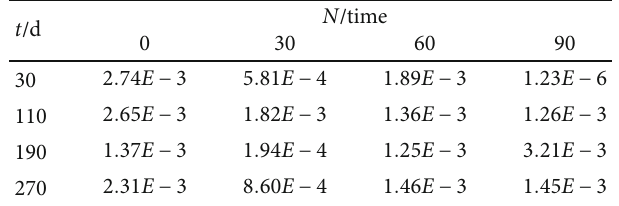
Table 5: Values of the parameter dx of di ff erent freeze-thaw cycles and corrosion time.